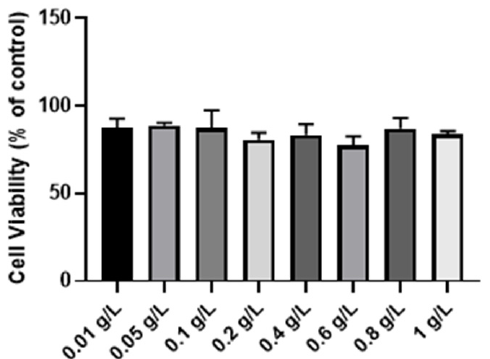
Figure 6. Effect of CD F on the cellular viability of human SH-SY5Y cells, with cells being cultivated in the presence of increasing concentrations of CDs. Values of cell viability are expressed in percentage and represent mean ± SEM of 3 independent experiments (n = 3).